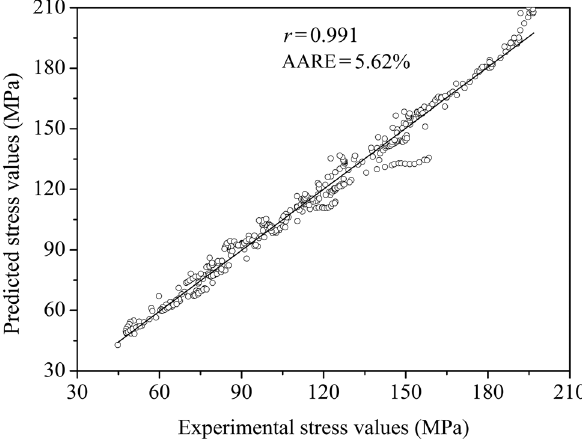
Figure 12: Correlation between the experimental flow-stress data and those predicted using the constitutive